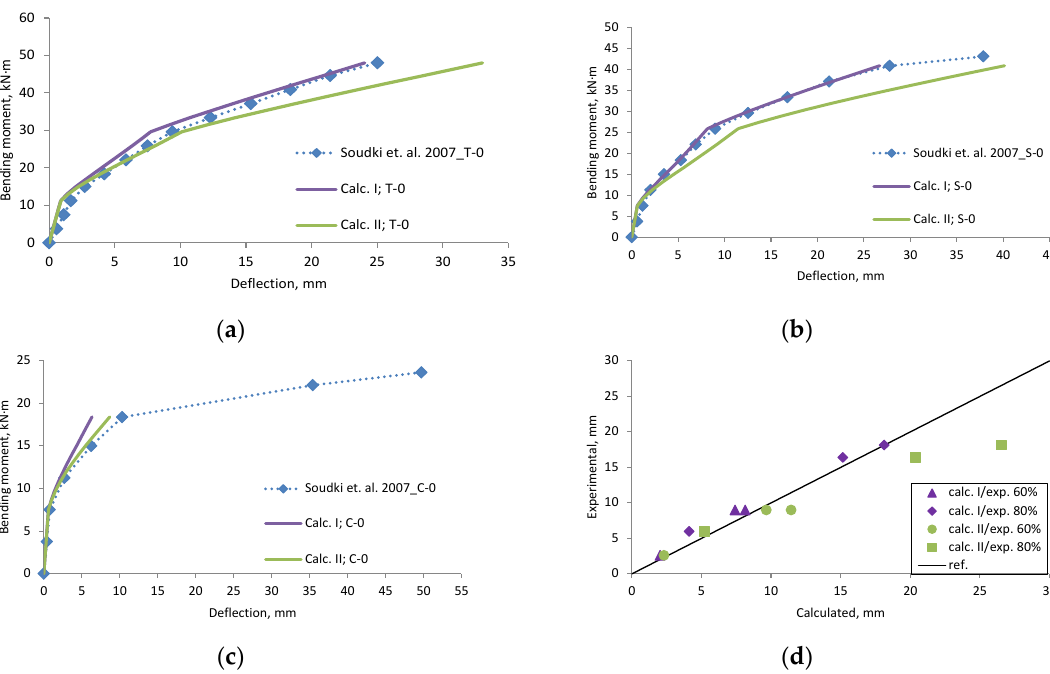
Figure A18. Soudki et al., 2007 [41] research beams deflection compared with calculated, ( a ) beam T-0; ( b ) beam S-0; ( c ) beam C-0; ( d ) scatter of the results at 60% and 80% of the ultimate load.